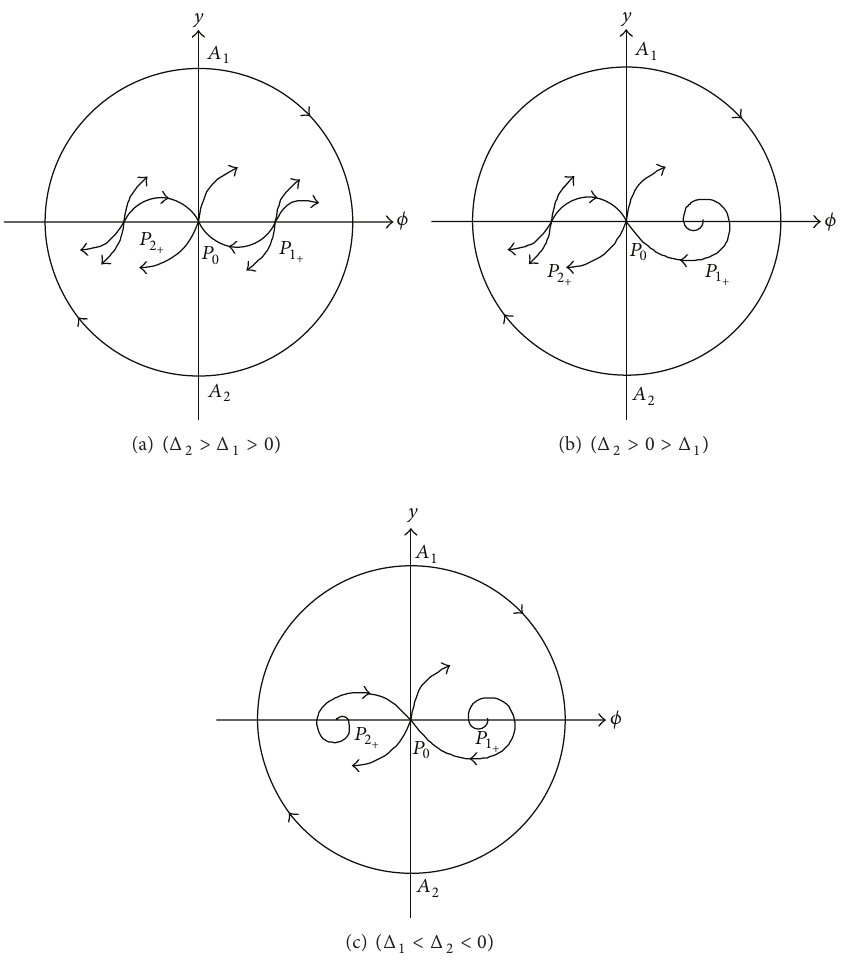
Figure 5: ( 𝛽 > 0 , 𝑎 < 0 , 𝑏 > 0 , 𝑐 > 0